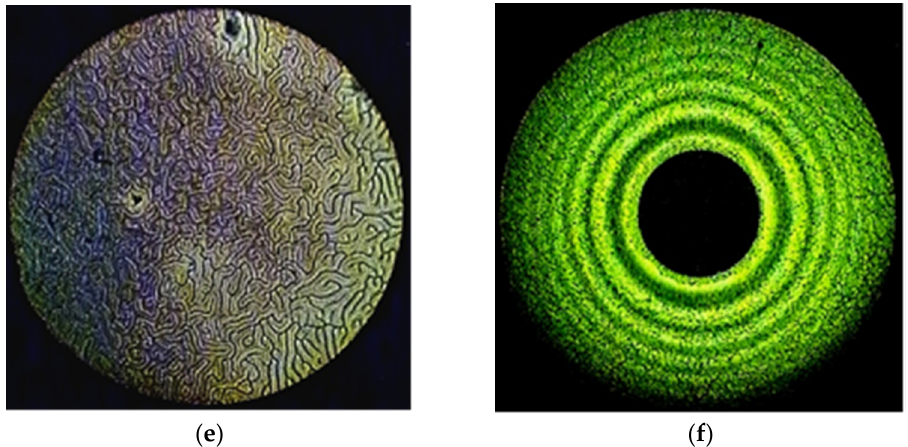
Figure 2. The “ fingerprints ” texture of the mixtures CB-2 with ( a ) 1.54% Ni-MADMECl; ( c ) 1.96% Cu-MADMECl; ( e ) 3.36% Zn-MADMECl at 70 °C. The system of Newton’s rings of the same mix- tures at 25 °C (wavelength of monochromatic light 551 nm) with ( b ) 1.54% Ni-MADMECl; ( d ) 1.96% Cu-MADMECl; ( f ) 3.36% Zn-MADMECl.